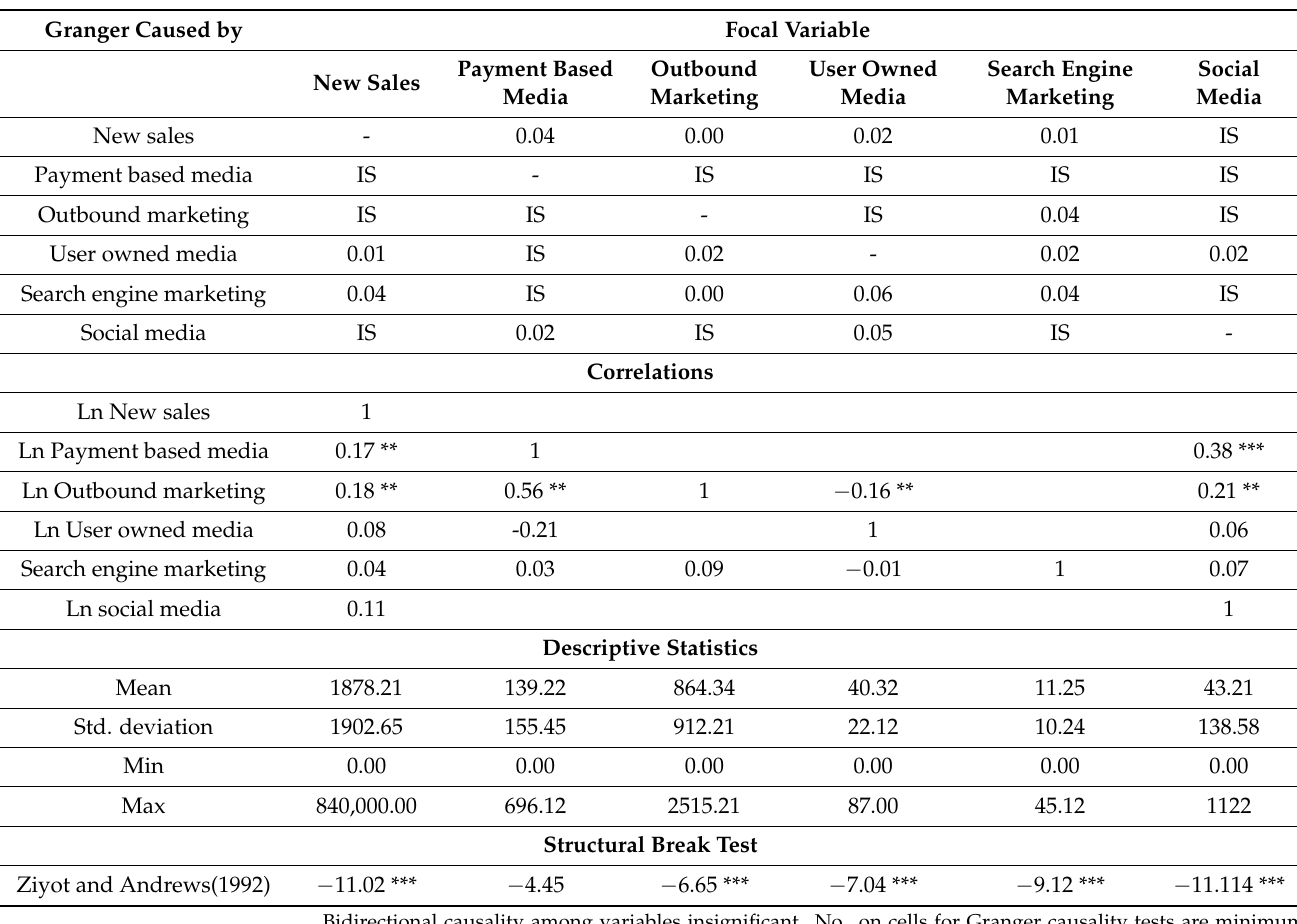
Table 6. Granger causality test, correlation, and structural break